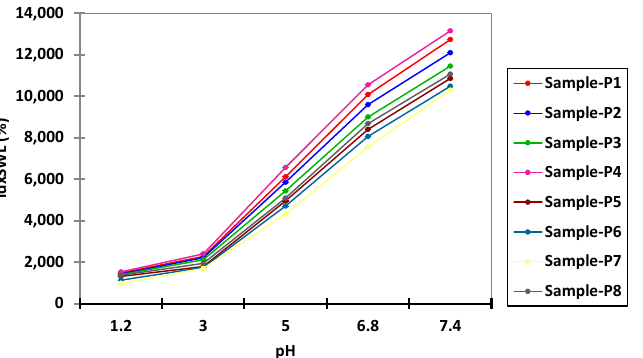
Figure 3. Interval plots of the swelling index (idxSWL (%)) of the microspheres for Sample * pH interaction factor levels.